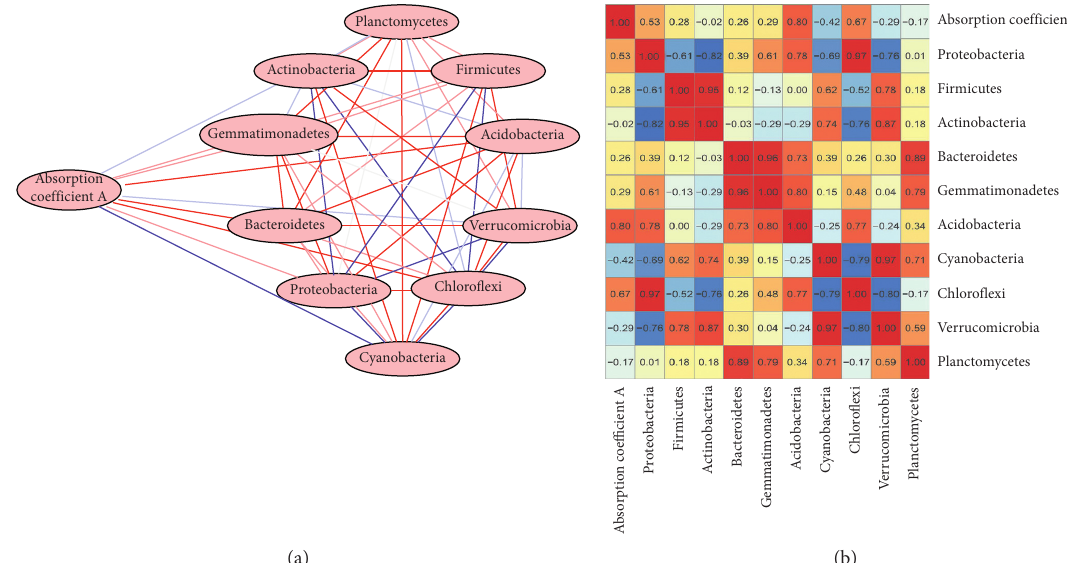
Figure 6: The correlation between capillary absorption coefficient A and abundance of bacterial phyla is shown in a network (a). Positive correlations are displayed with red lines and negative correlations with blue lines. The darker the color, the higher the correlation. The heatmap (b) shows the correlation